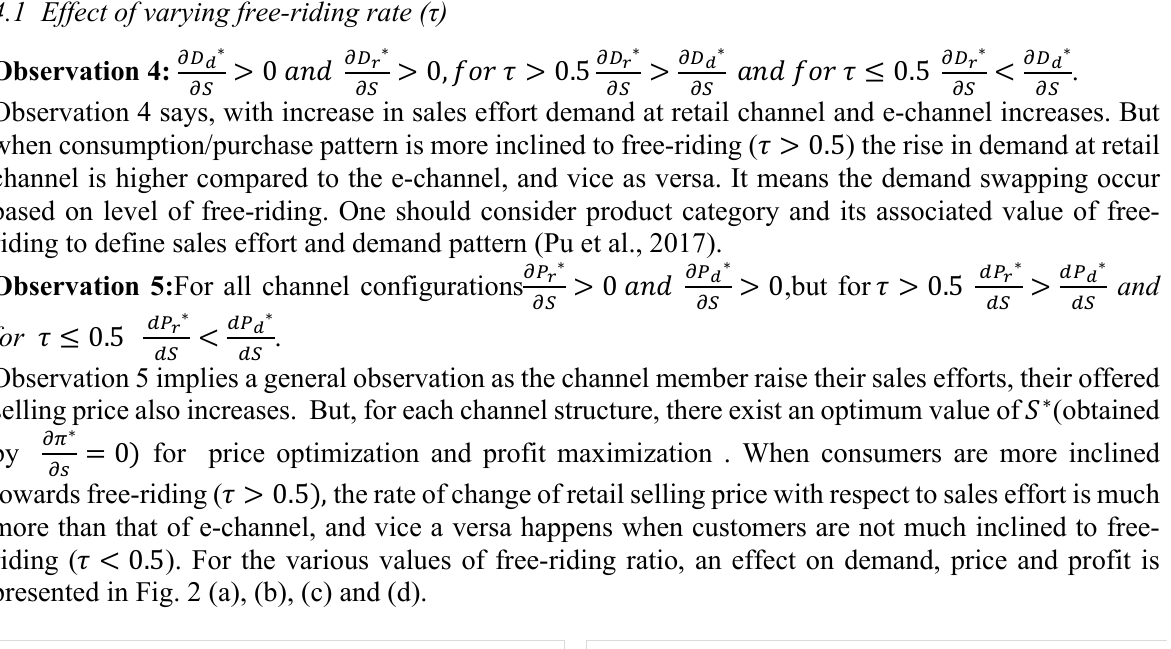
Fig. 3. (a) π m (VID-SC) v/s t Fig. 3. (b) π m (DD-SC) , π r (DD-SC) , π d(DD-SC) , P r , P d , W r and W d v/s t